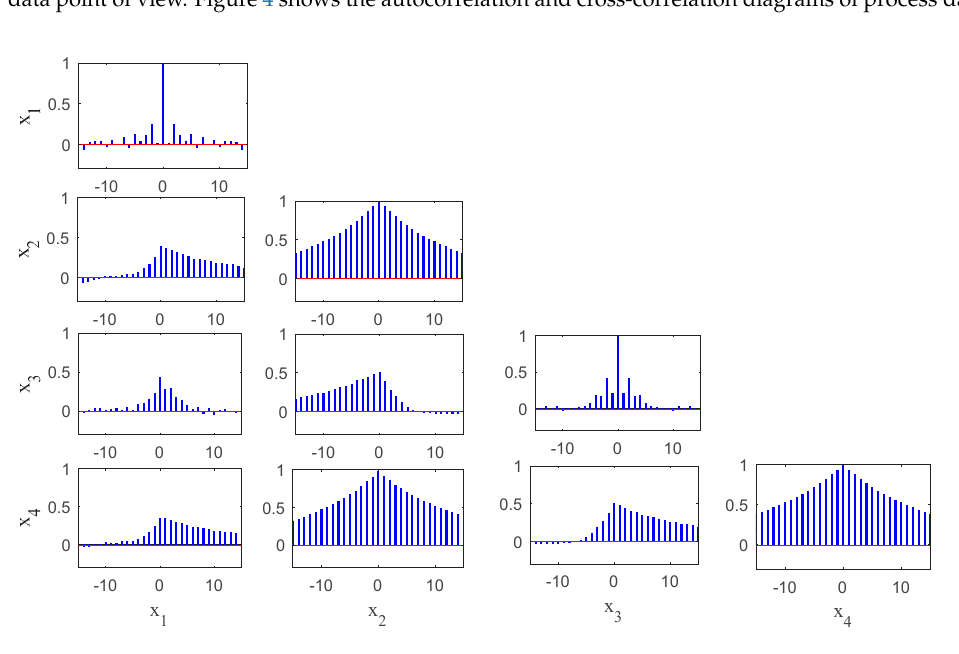
First, analyze the dynamics of the data and the time lag characteristics of the variables from the data point of view. Figure 4 shows the autocorrelation and cross-correlation diagrams of process data.